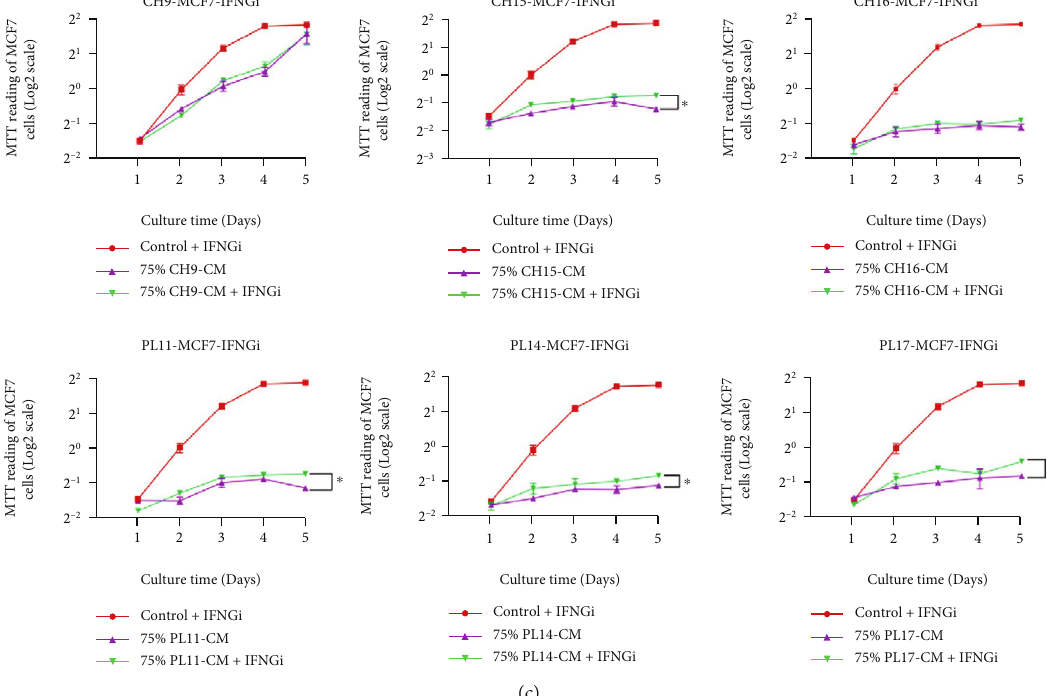
Figure 8: The e ff ect of DKK1, TGF- β , and IFN- γ on the proliferation of human breast cancer MCF-7 cells in the presence of soluble factors derived from PL-hMSCs and CH-hMSCs. (a) Graphs show the growth kinetics of MCF-7 cells cultured in 75% conditioned medium derived from CH-hMSCs and PL-hMSCs supplemented with the DKK1 antagonist CHIR99021 (75% CH-CM+CHIR and 75% PL-CM+CHIR, respectively) as determined by the MTT assay. Data are presented as mean ± SEM of four experiments. MCF-7 cultured in DMEM medium +10% FBS supplemented with CHIR99021 (control+CHIR) served as controls. (b) Graphs show the growth kinetics of MCF-7 cells cultured in 75% conditioned media derived from CH-hMSC and PL-hMSCs supplemented with TGF- β inhibitor SB431542 (75% CH-CM+SB and 75% PL-CM+SB, respectively) as determined by the MTT assay. Data are presented as mean ± SEM of four experiments. MCF-7 cultured in DMEM medium +10% FBS supplemented with SB431542 (control+SB) served as controls. (c) Graphs show the growth kinetics of MCF-7 cells cultured in 75% conditioned media derived from CH-hMSC and PL-hMSCs supplemented with IFN- γ neutralizing antibody XMG1.2 (75% CH-CM+IFNGi and 75% PL-CM+IFNGi, respectively) as determined by the MTT assay. Data are presented as mean ± SEM of four experiments. MCF-7 cultured in DMEM medium +10% FBS supplemented with XMG1.2 (control+IFNGi) served as controls. ∗ P < 0 : 05 between the compared groups. CH-CMs were prepared from 3 CH-hMSCs (CH9, CH15, and CH16), and PL-hMSC-CMs were prepared from 3 PL-hMSCs (PL11, PL14, and